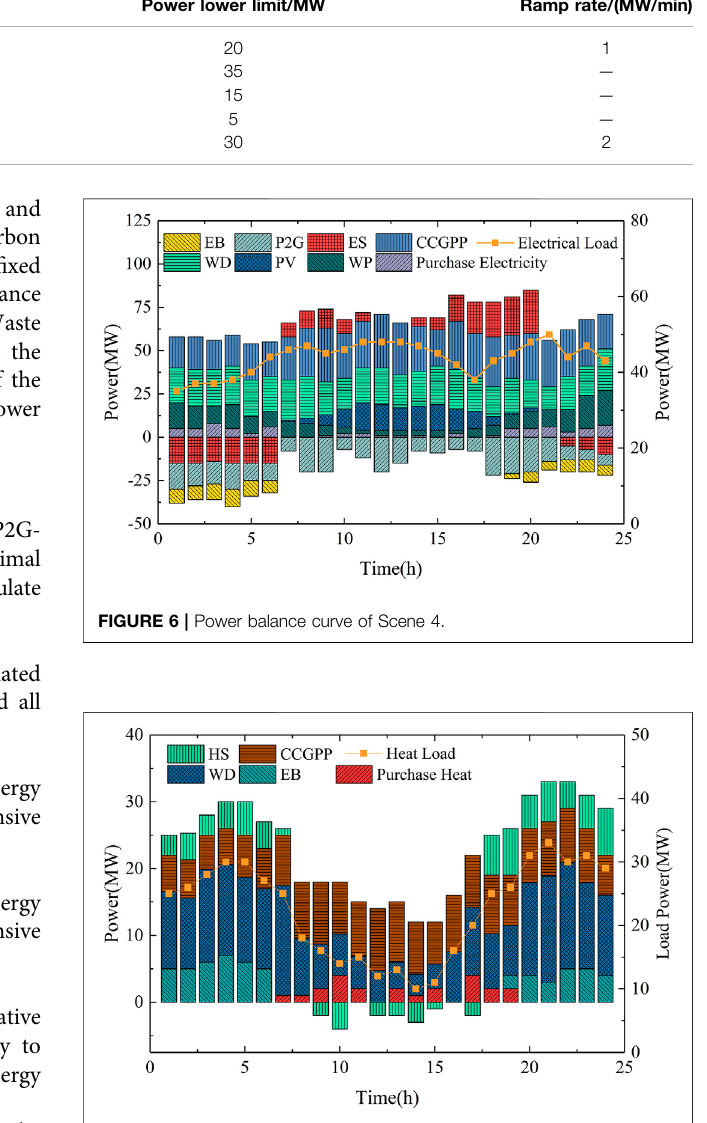
FIGURE 7 | Thermal balance curve of Scene